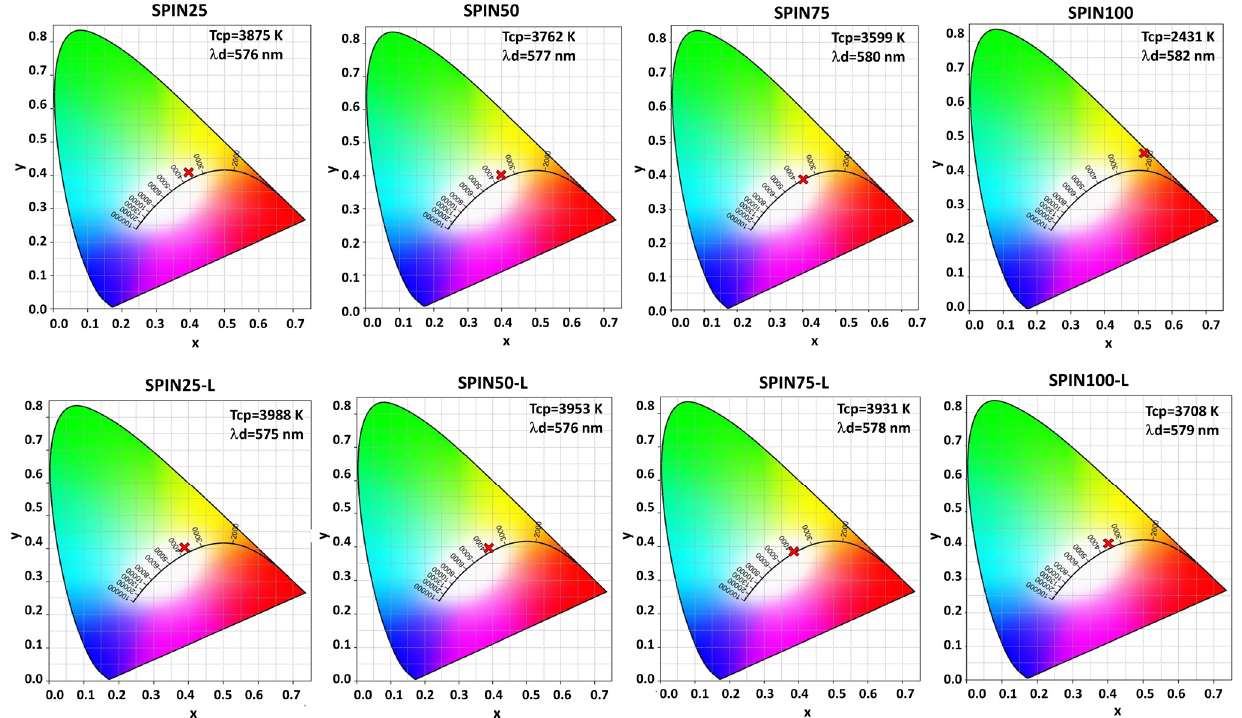
Figure 8. Chromaticity diagram of the light emitted by the LED recorded in the presence of the PI-based supramolecular systems before and after laser exposure. PI-based supramolecular systems before and after laser